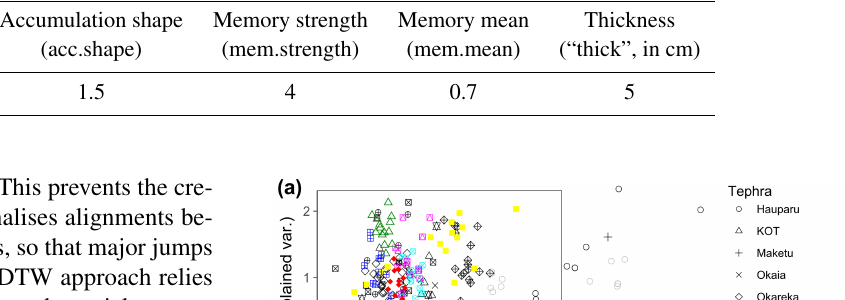
Table 1. Bacon prior parameters.